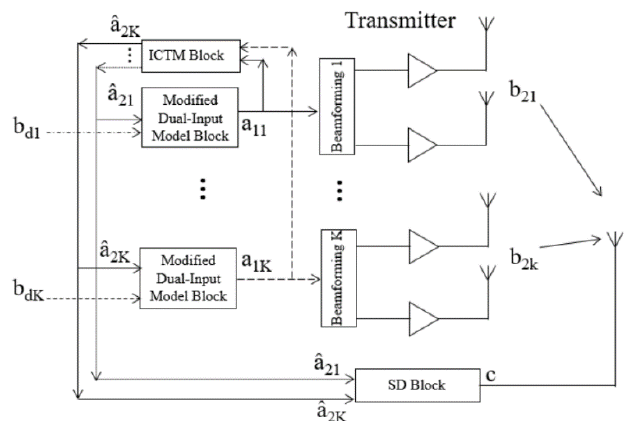
Figure 5. Block diagram representing the steps to apply the single-receiver OTA DPD with antenna crosstalk using OTA measurements